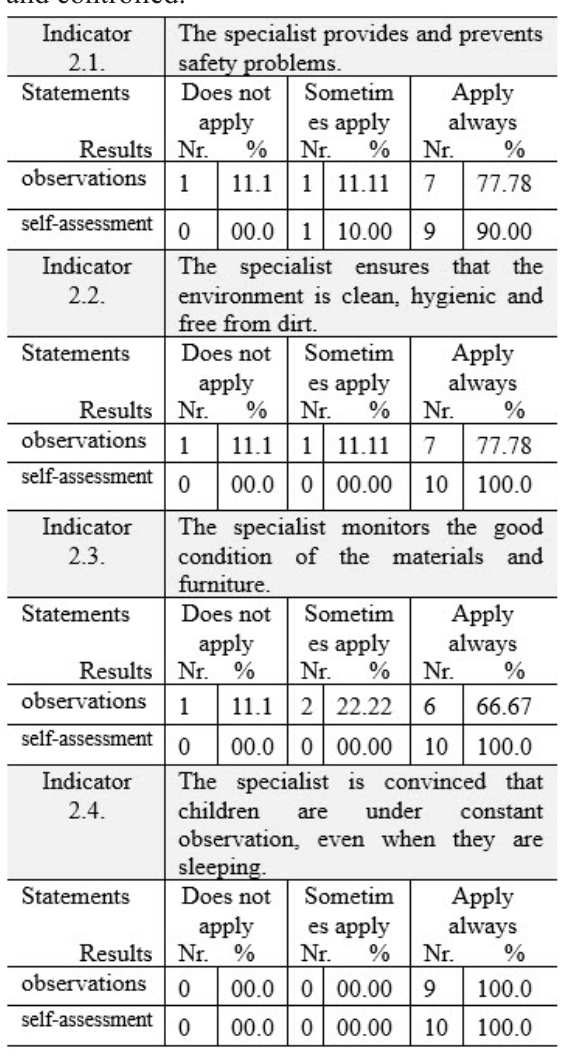
Table 27. Principle 2: The environment is safe, clean and free from all contamination and